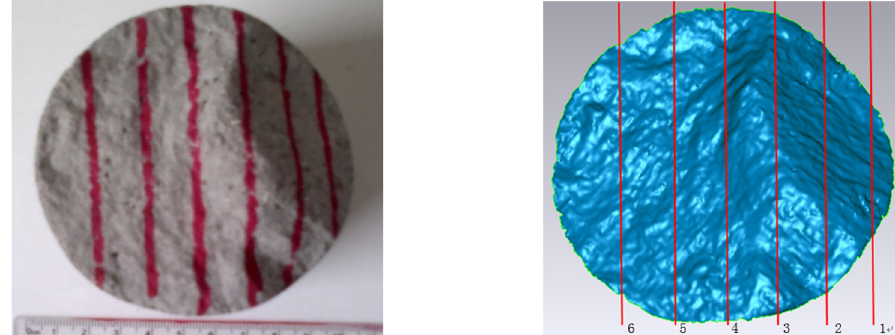
Figure 9: Section line of the structural